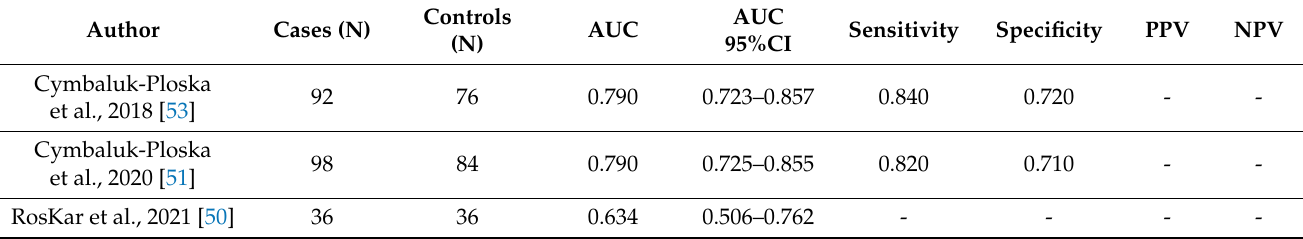
Table 10. Summary table of the performance of Leptin.